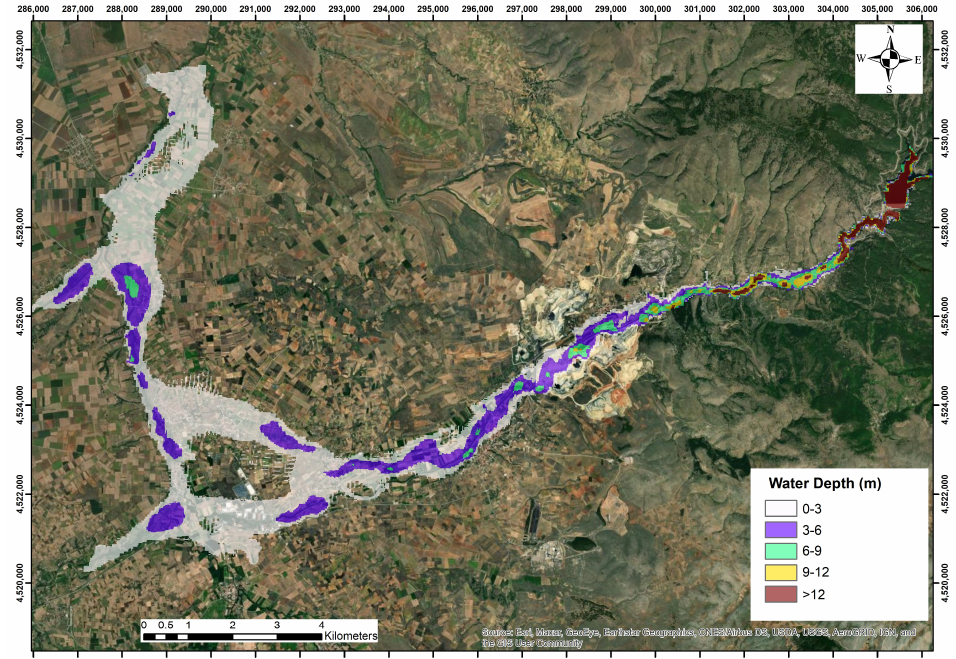
Figure 13. Maximum water depth and boundaries of inundated area in the case of overtopping dam